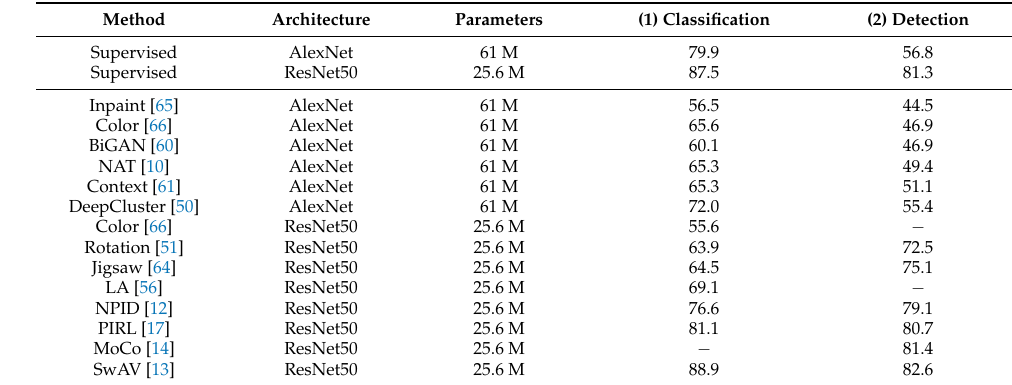
Table 3. (1) Linear classification top-1 accuracy on top of frozen features and (2) object detection with fine-tuned features on VOC7+12 using Faster-CNN.